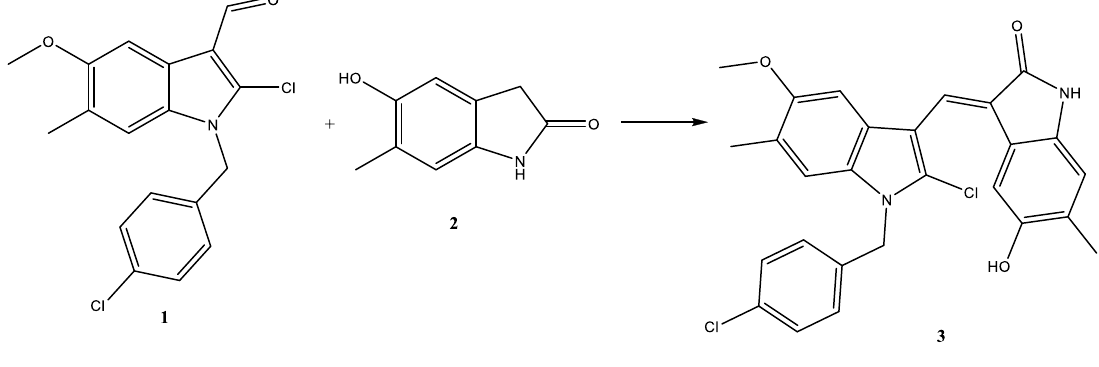
Scheme 1. Synthesis of compound 3 [25].